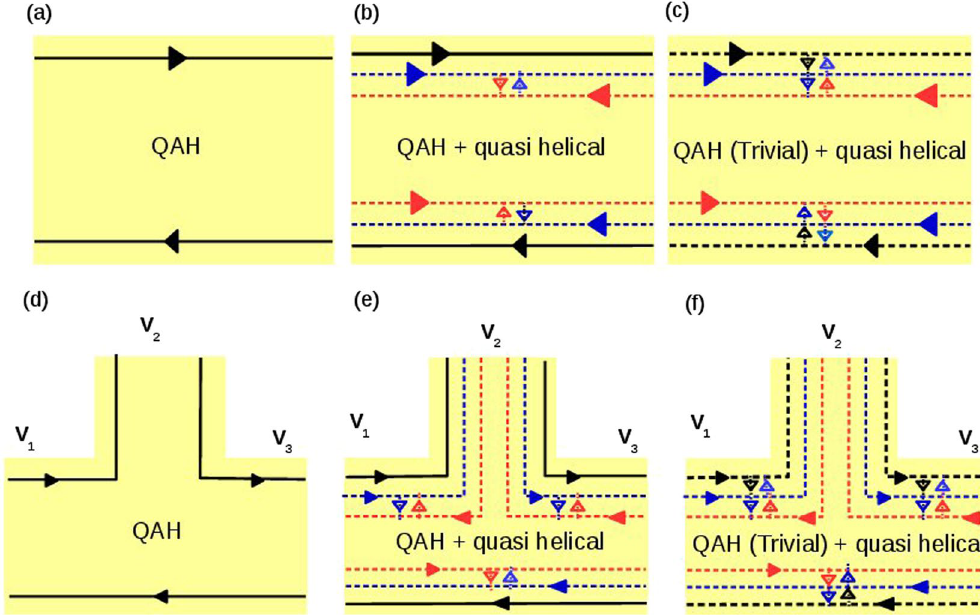
Figure 1. Two and three terminal QAH bar: Topological chiral QAH edge mode is shown by solid black line, and quasi-helical QSH edge modes are shown by colored dashed line (red for spin up, blue for spin down). Trivial chiral QAH edge mode is shown by black dashed line. Intra edge back scattering is shown by arrows between the edge modes. Top panel: Two terminal QAH bar: ( a ) single topological QAH edge mode, ( b ) single topological QAH edge mode with quasi-helical QSH edge modes and ( c ) single trivial QAH edge mode with quasi-helical QSH edge modes, Bottom panel: Three terminal QAH bar: ( d ) single topological QAH edge mode, ( e ) single topological QAH edge mode with quasi-helical QSH edge modes and ( f ) single trivial QAH edge mode with quasi-helical QSH edge